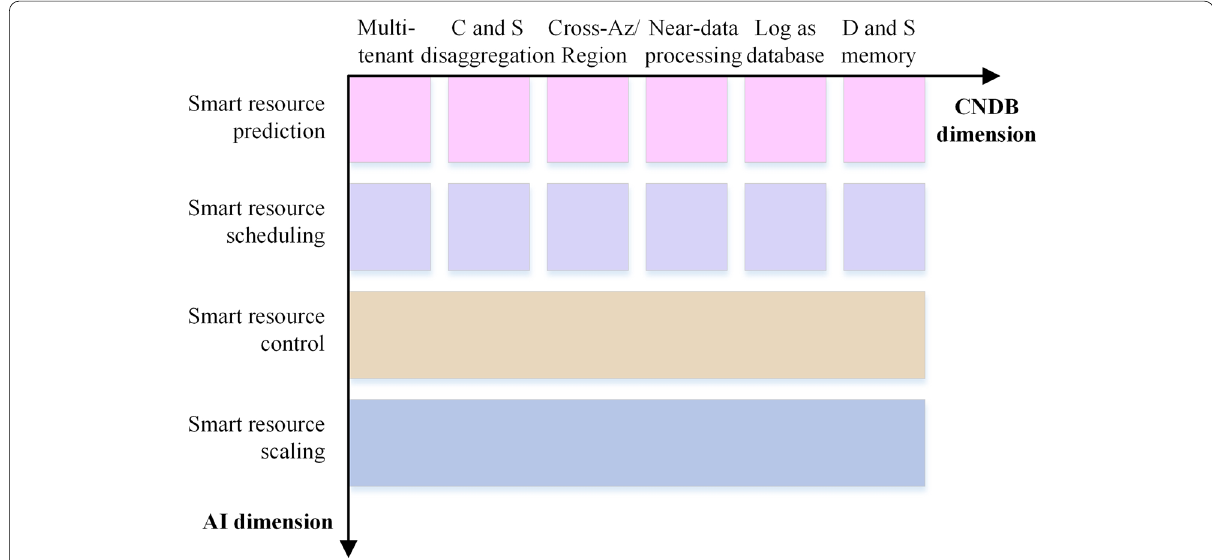
Fig. 2 Indicator matrix for AI-empowered CNDBs